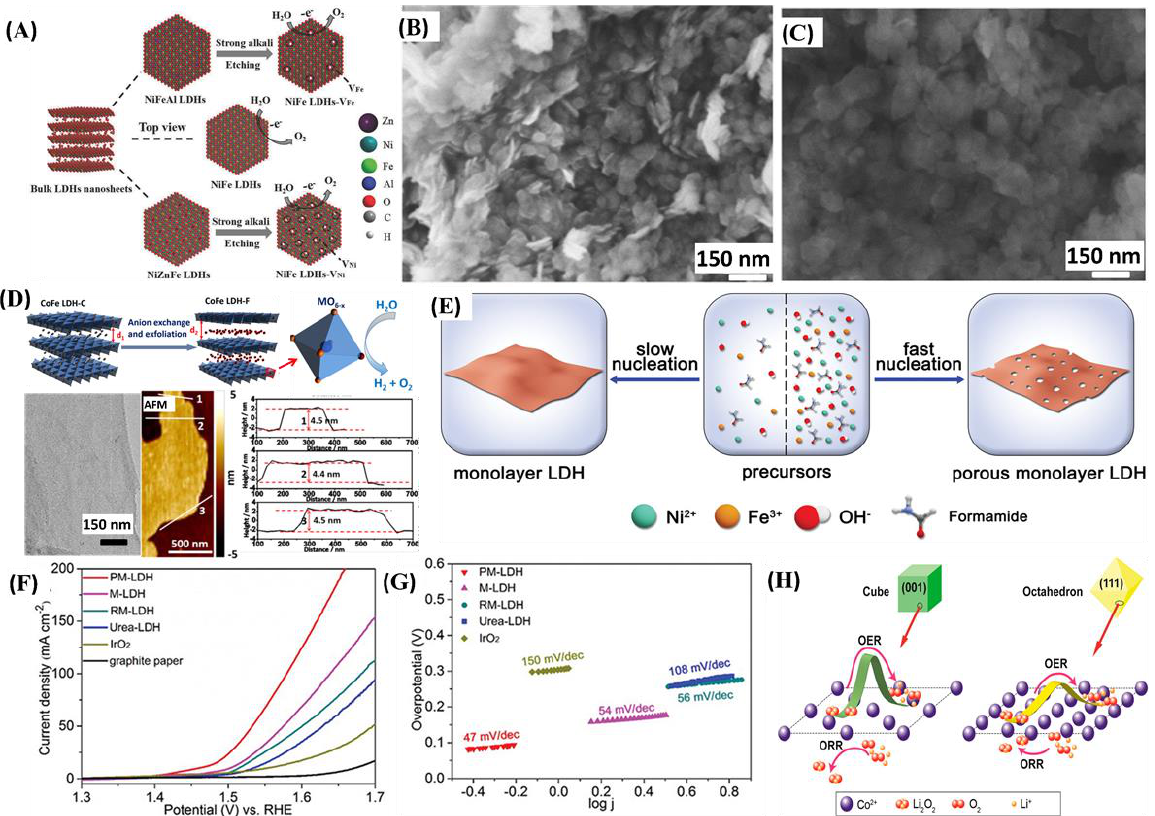
Figure 6. ( A ) The synthesis of NiFe LDHs-V Fe and NiFe LDHs-V Ni by strong alkali etching LDHs. ( B ) SEM image of NiFe LDH-V Fe . ( C ) SEM image of NiFe LDH-V Ni . Reproduced with permission from [86]. WILEY-VCH Verlag GmbH & Co. KGaA, Weinheim, 2018. ( D ) Schematic illustration of exfoliation of CoFe LDH, and transmission electron microscopy (TEM) and AFM images. Reproduced with permission from [89]. American Chemical Society, 2016. ( E ) Schematic illustration of synthesis of porous monolayer LDH and monolayer LDH. ( F ) LSV curves at a scan rate of 5 mV s −1 . ( G ) Corresponding Tafel slopes. Reproduced with permission from [90]. WILEY-VCH Verlag GmbH & Co. KGaA, Weinheim, 2019. ( H ) Schematic illustration of the facet-dependent electrocatalytic mechanism of ORR and OER on Co 3 O 4 (001) and Co 3 O 4 (111), respectively. Reproduced with permission from [94]. American Chemical Society, 2015.